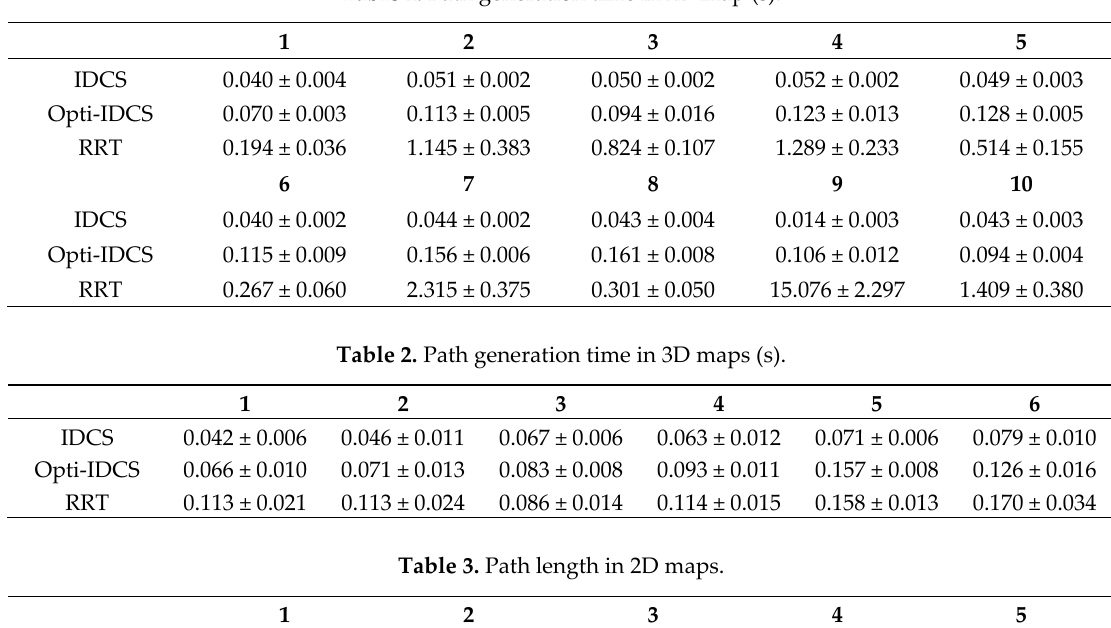
Table 1. Path generation time in 2D map (s).